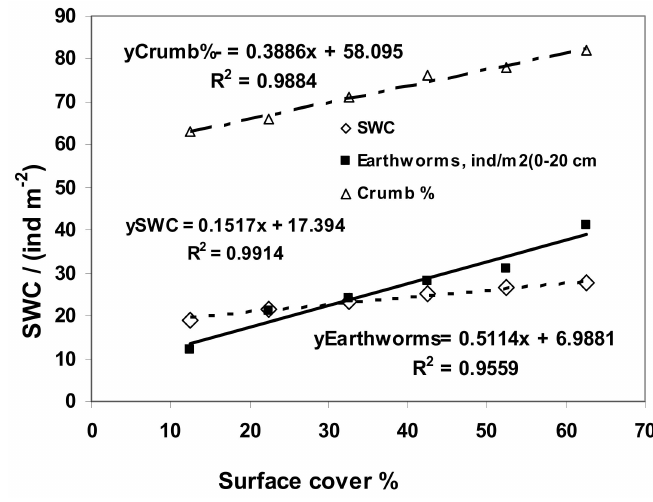
Figure 5. Surface cover impact on soil SWC, earthworm abundance and crumb ratio in Chernozem